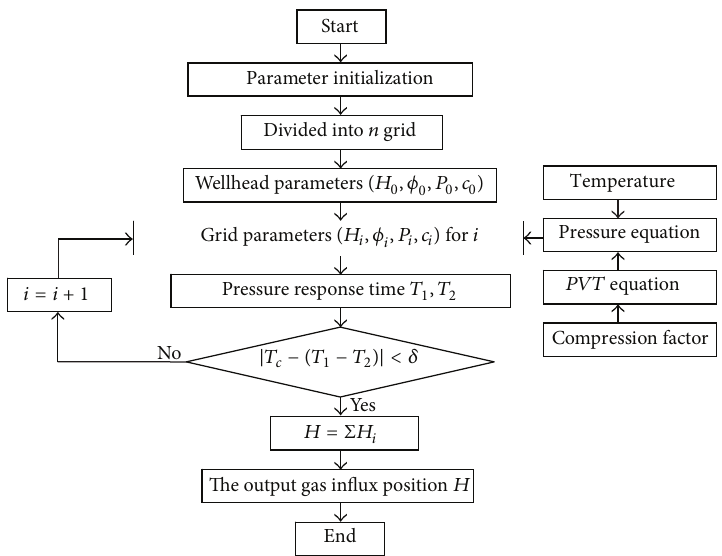
Figure 2: Solution procedure for gas influx position in MPD operations.